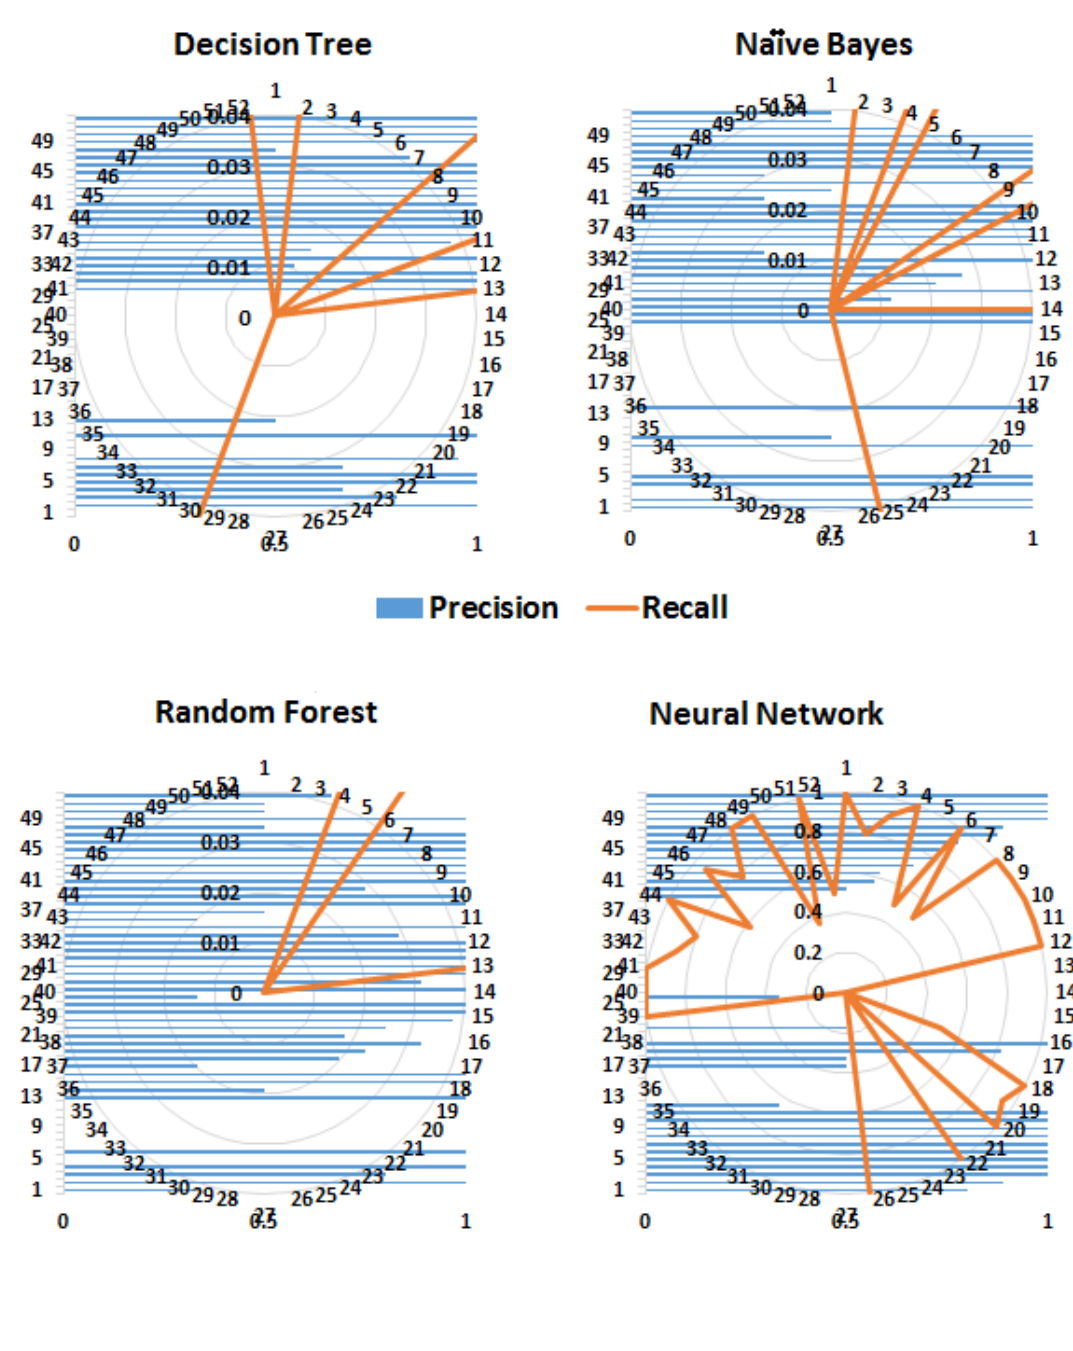
Figure 6. Precision analysis of classification algorithms for 52 classes (diseases) shown in Table 6. Precision and recall values decrease from the outermost (value 1) to the innermost circle (value 0). The curves lying on the outermost circle represent better classification results, such as those by the decision tree and random forest